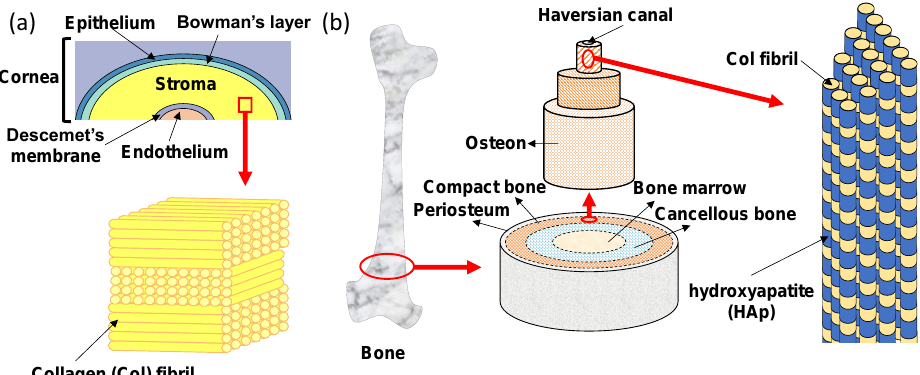
Figure 2. Oriented tissue Col structures of ( a ) human cornea and ( b ) bone.